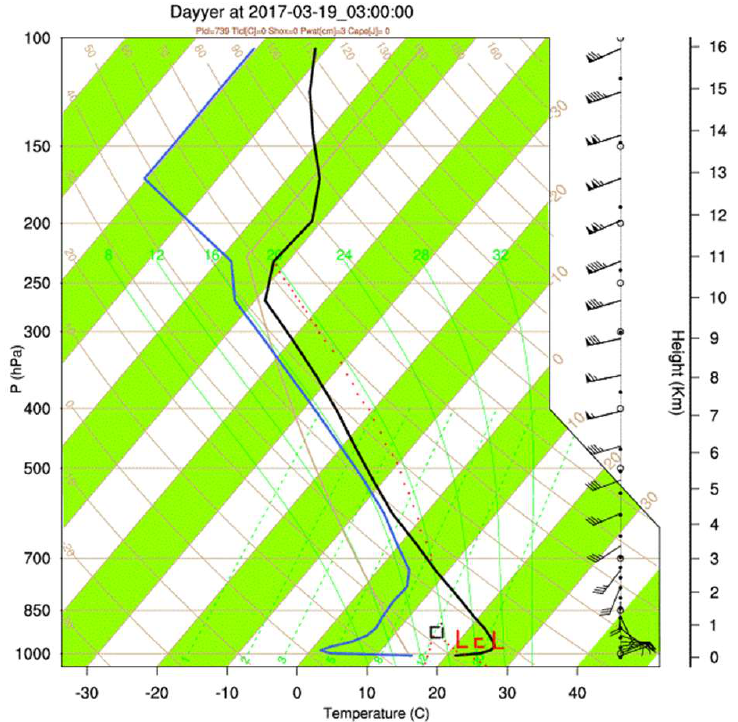
Figure 9. The Skew-T chart for 51°10′ E and 27°30′ N for 3:00 UTC of 19 March. The solid black line presents the temperature profile, while the solid blue line presents the dew point temperature profile. The black rectangle indicates the lifted condensation